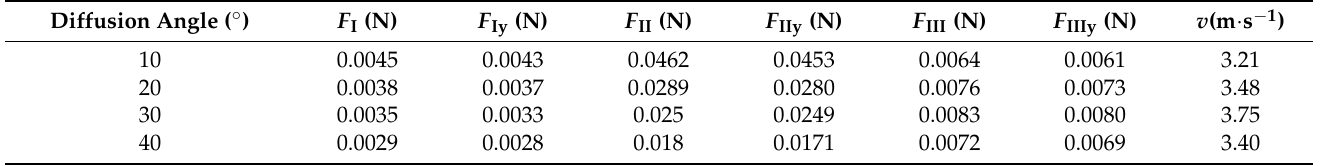
Table 3. Mean ejection velocities and mean forces at each stage of seed movement.